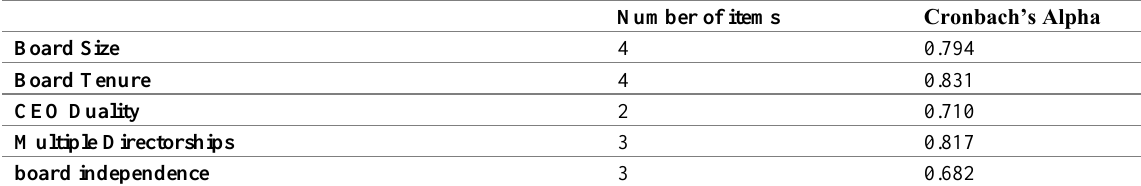
Table 4: Cronbach’s Alpha